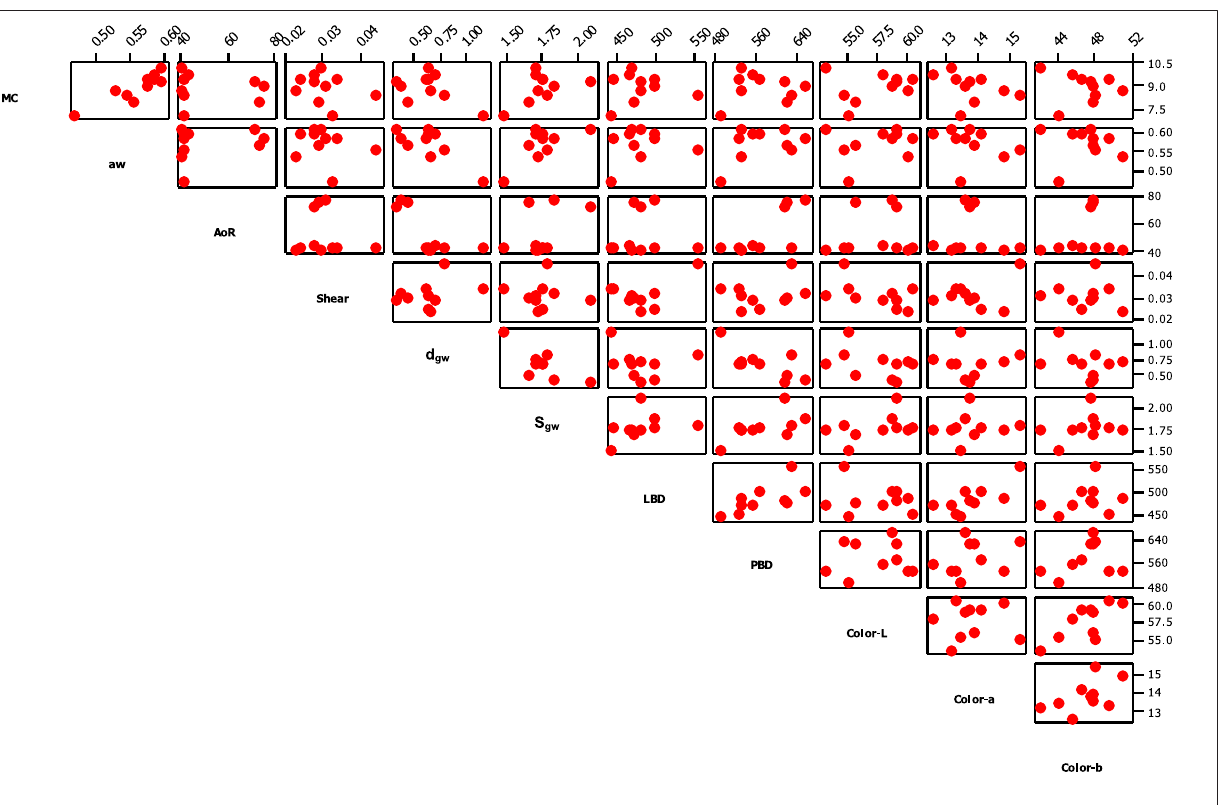
FIGURE 2 | Scatterplot matrix for all dependent variables, which illustrates any potential trends and clusters in the data.